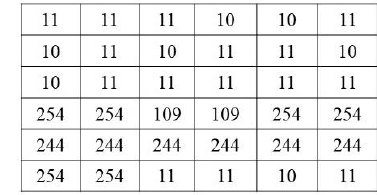
Figure 10. Distribution plot of C R obtained by LZMA